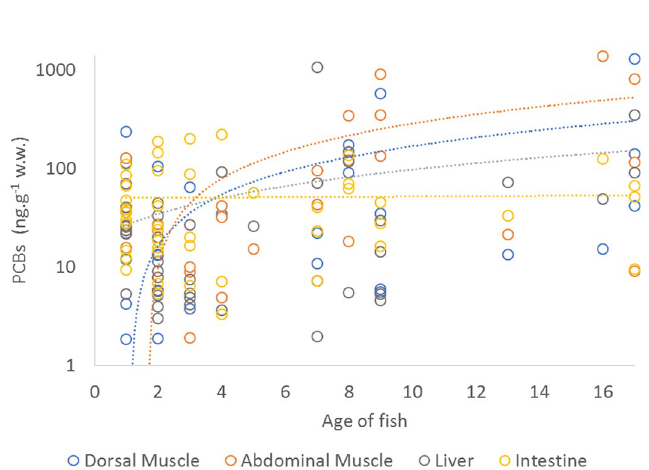
Figure 2. Mean concentrations of PCBs in fish matrices (ng g −1 w.w.) in relation to fish age.